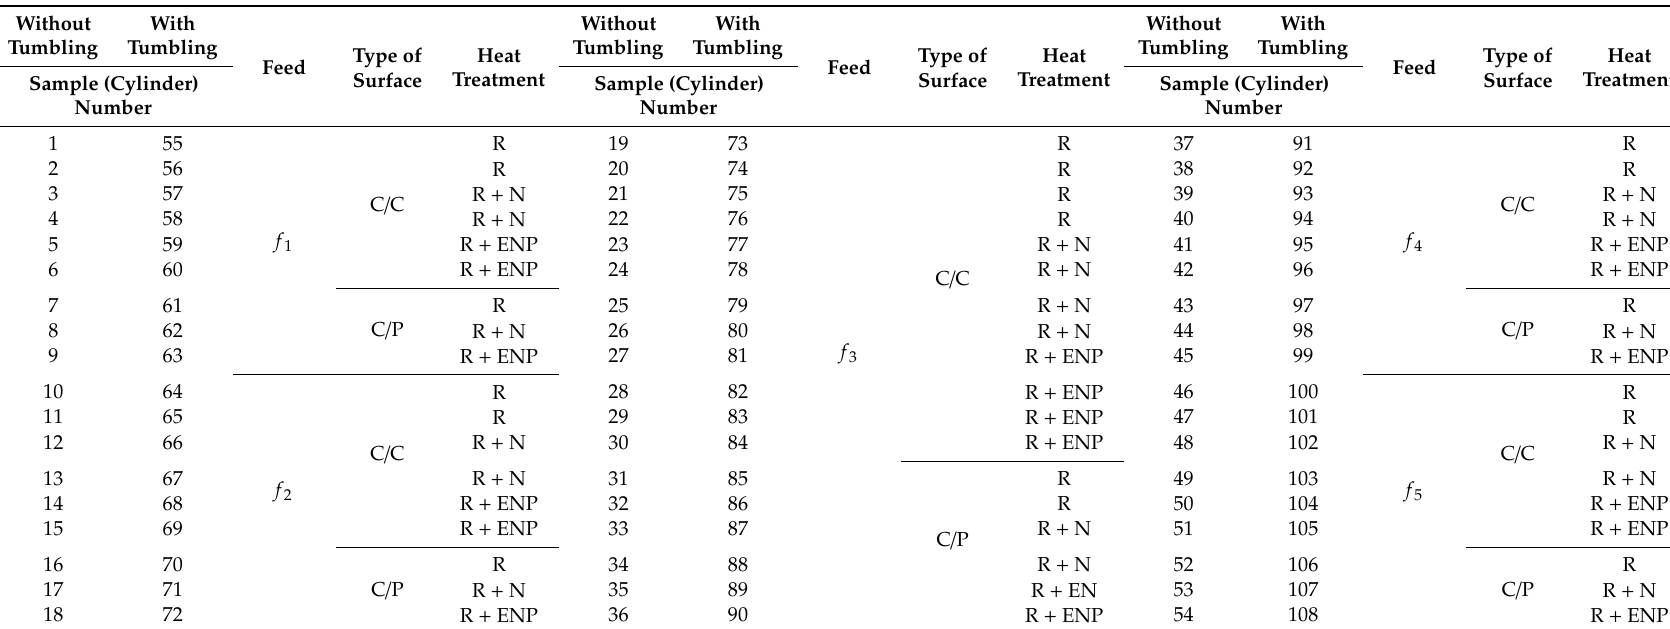
Table 2. Samples with an assigned number and associated characteristics (C / C—Cylinder / Cylinder contact type; C / P—Cylinder / Plane contact type; R—refinement; N—nitriding, ENP—Electroless Nickel